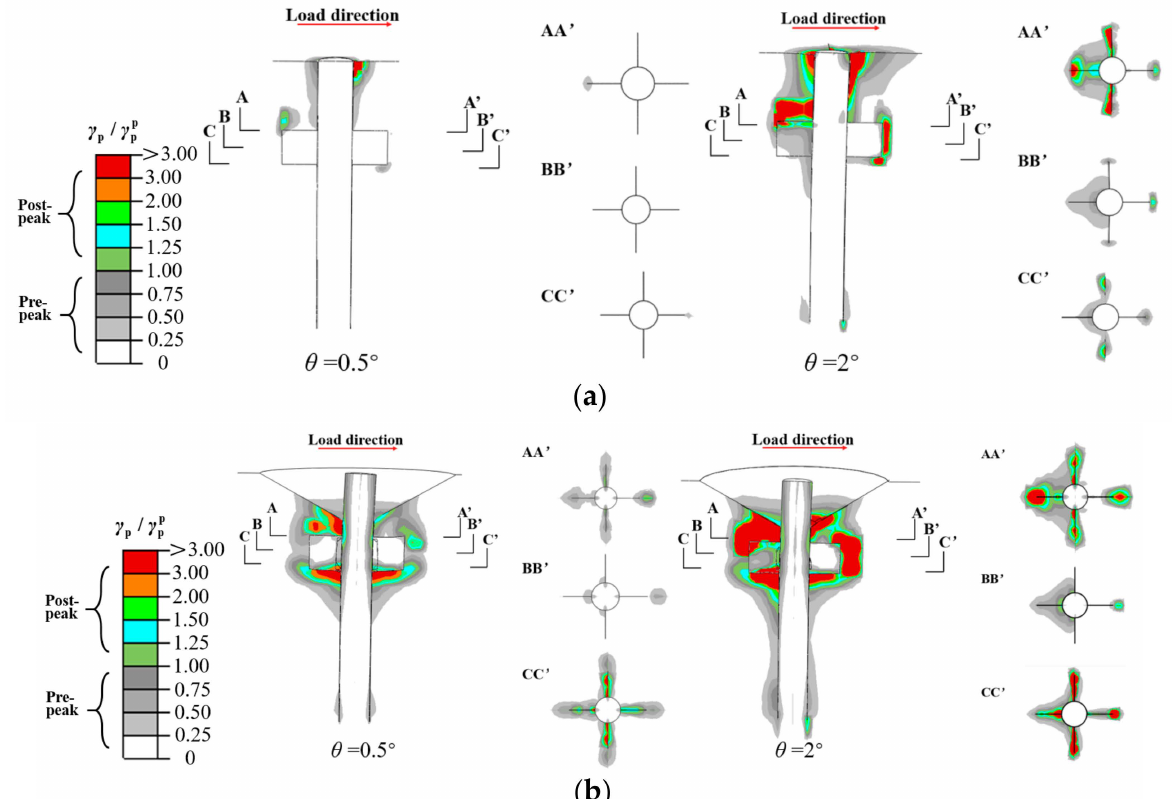
Figure 10. Distribution of plastic shear strain in the plane of symmetry of the winged monopile (WP4): ( a ) without local scour; ( b ) with local scour ( S/D =